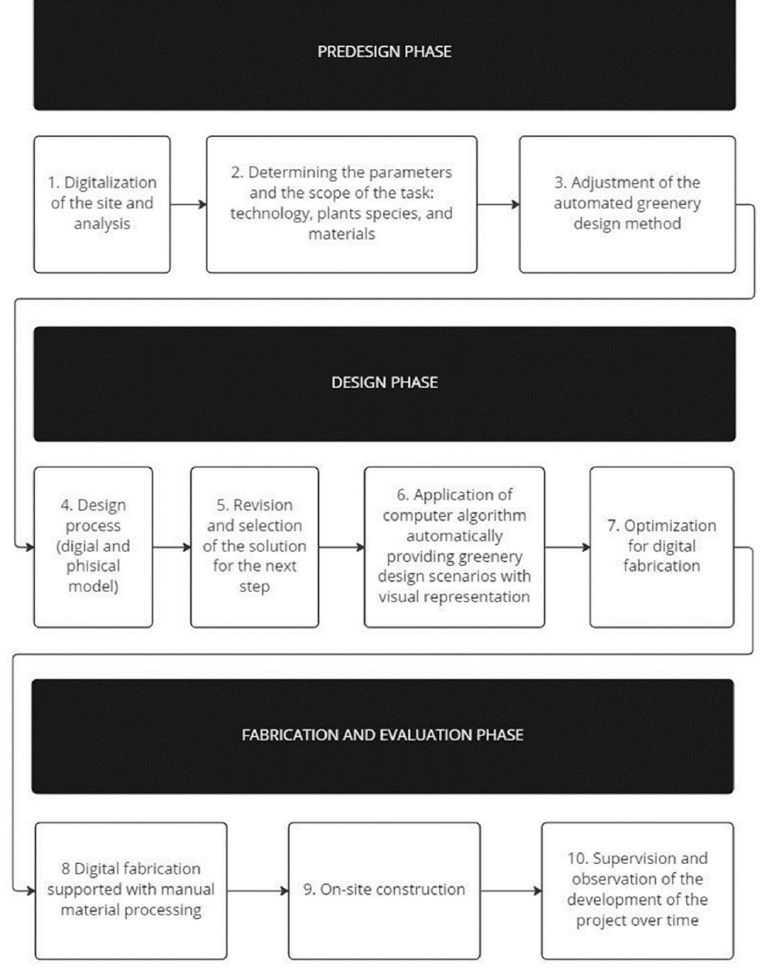
Figure 1. Method